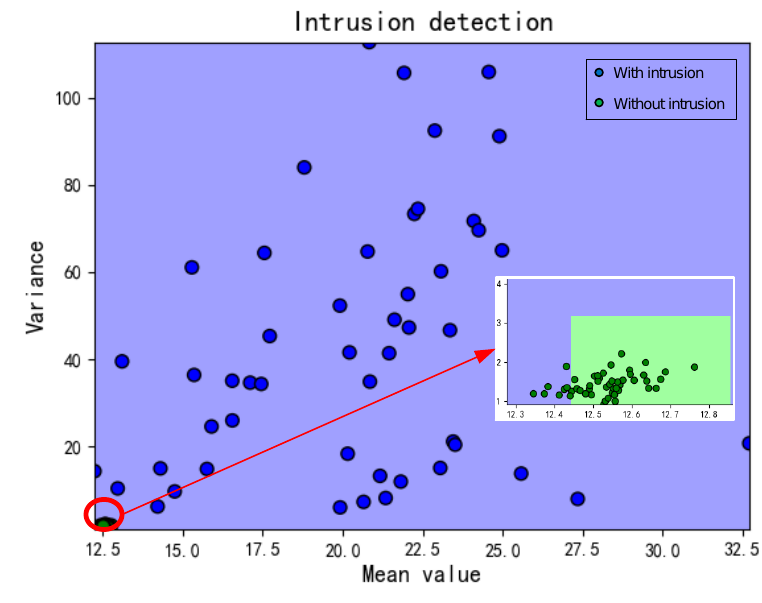
Figure 9. Detection results. Table 1. Devices used in